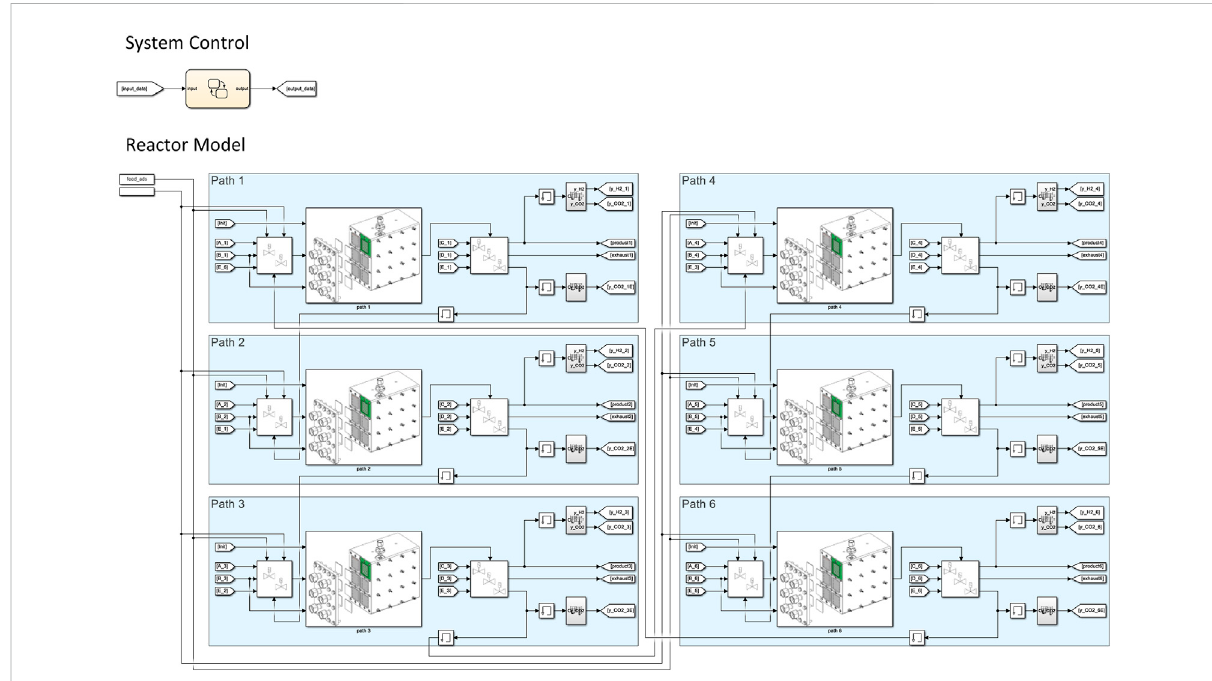
FIGURE 3 Simulink model on system scale. Six reaction chambers (Reactor Model) can optionally be interconnected via valves. After an initialization step, the chambers operate alternately either in reactive adsorption or in regeneration mode to deliver a continuous product fl ow. The State fl ow chart (yellow) is responsible for the control (System Control) and adjusts the discrete states (valve positions) to enable automated operation Stadler et al. (2022b).